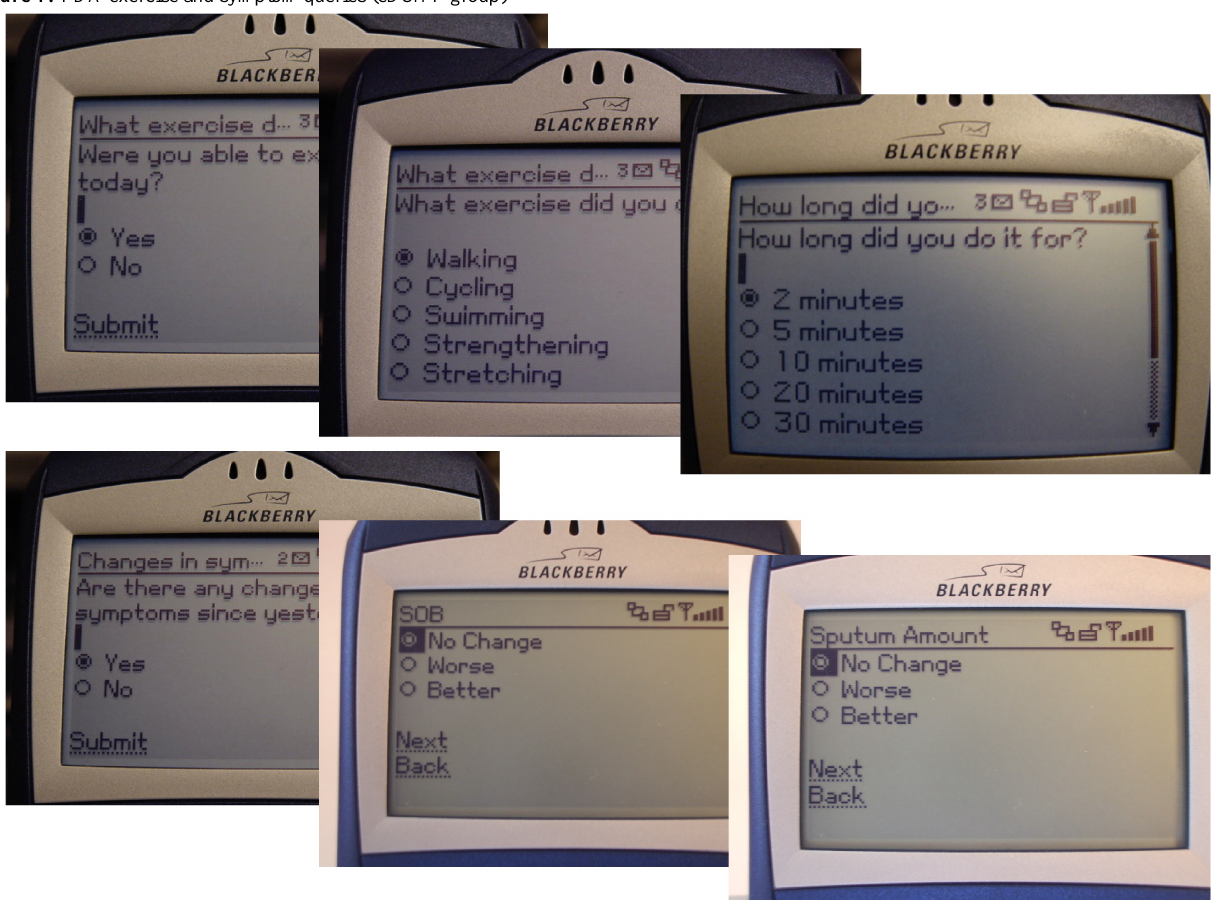
Figure 1. PDA exercise and symptom queries (eDSMP